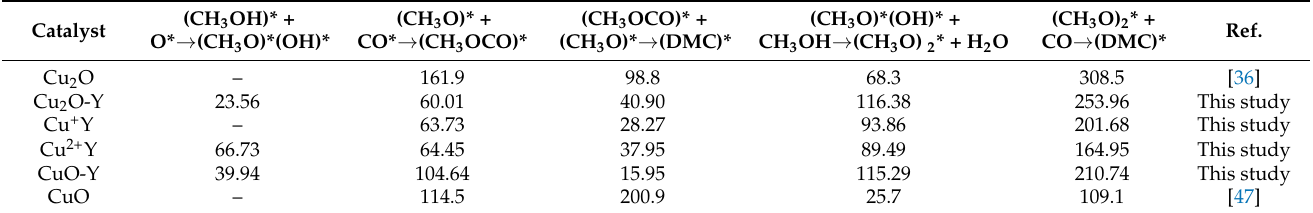
Table 3. The activation barriers for individual reaction steps based on two proposed reaction mecha- nisms (/kJ · mol − 1